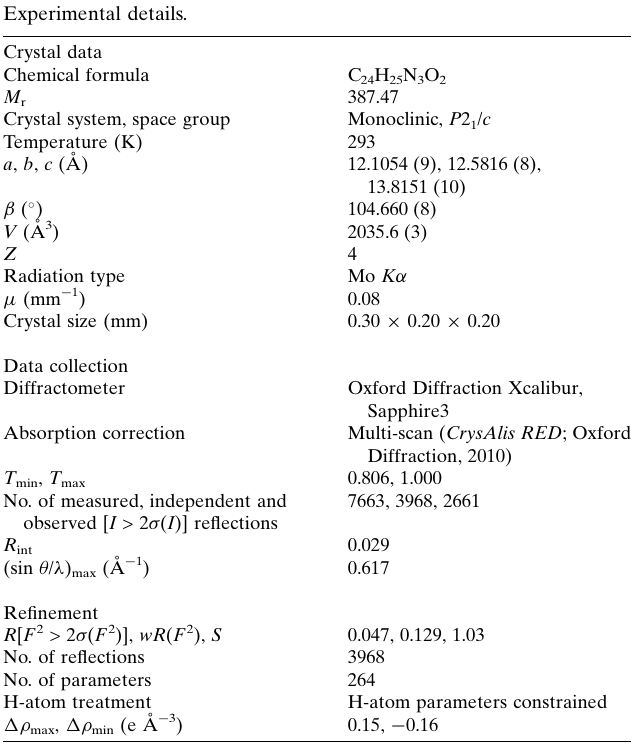
Table 2 Experimental details.